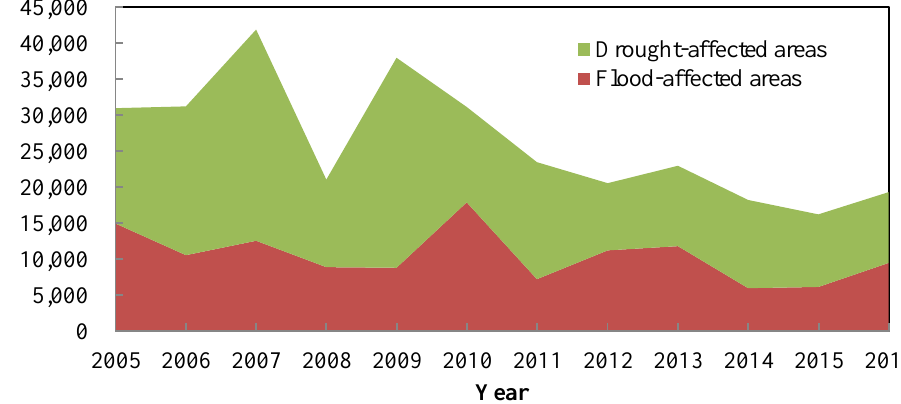
Figure 5. Flood-affected areas and drought-affected areas. Date source: Bulletin of Flood and Drought Disasters in China.